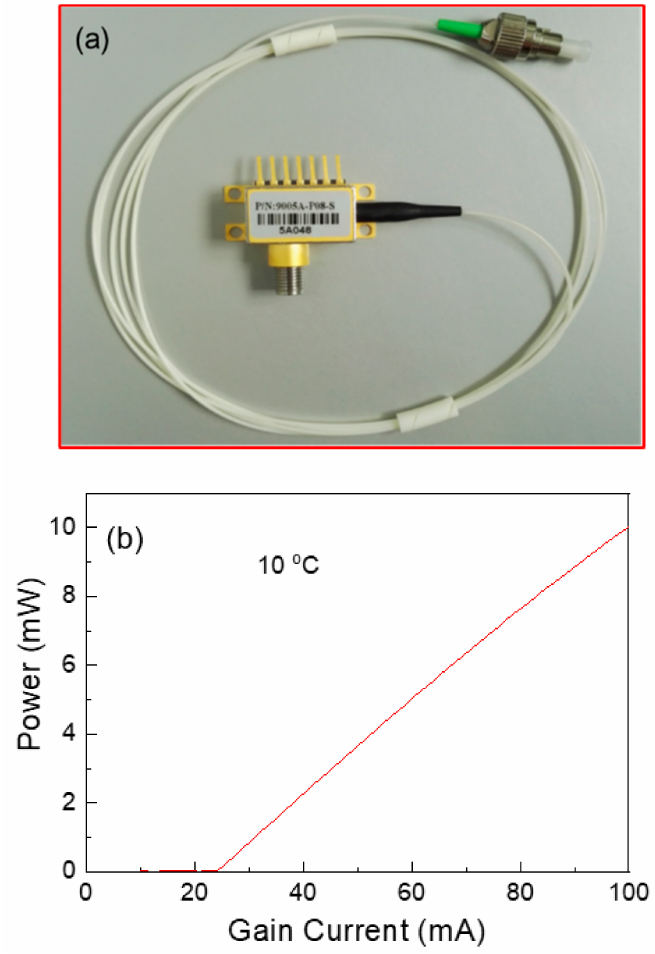
Figure 1. ( a ) Picture of a packaged distributed Bragg reflector (DBR) laser. ( b ) The light–current characteristic of the device at 10 ◦